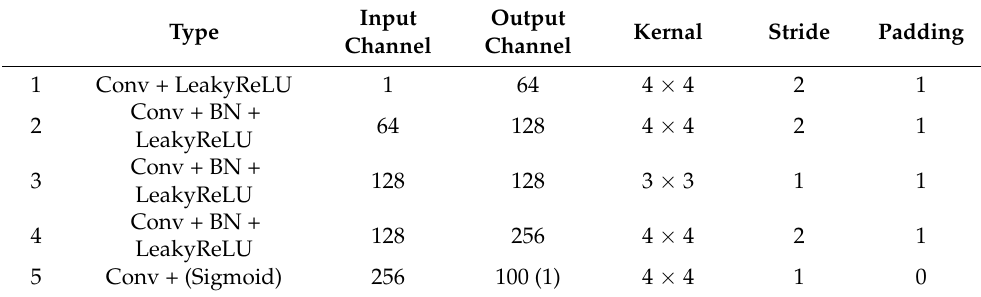
Table 1. The parameter configuration of the proposed model on submodules En 1 , En 2 and D . Type